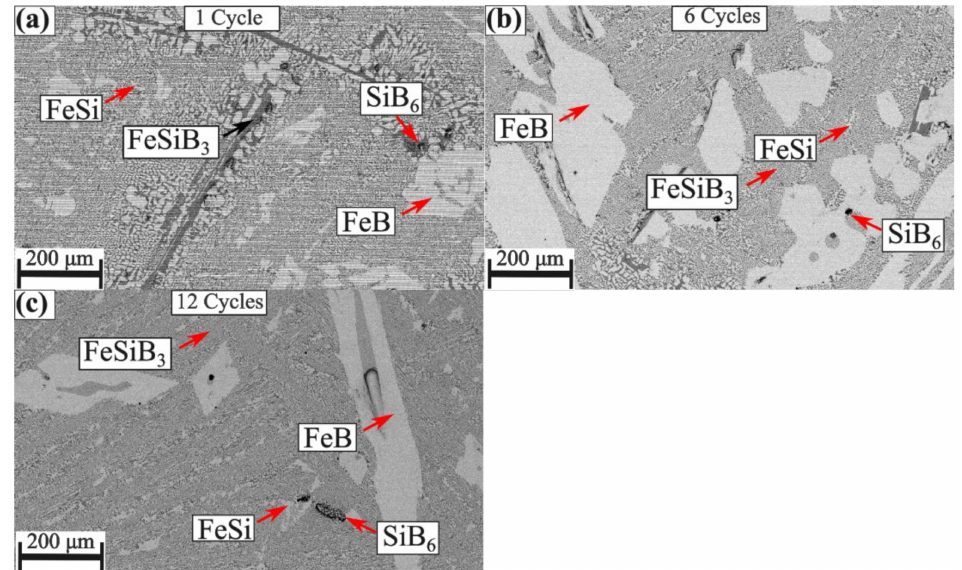
Figure 5. Images of the Fe-26Si-9B alloys after thermal cycle experiments. ( a ) one cycle; ( b ) six cycles; ( c ) twelve cycles.